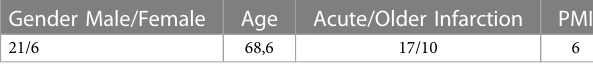
TABLE 1 Gender, mean Age (years), myocardial infarction (MI) age and mean postmortem interval (PMI, days) of the myocardial infarction group.